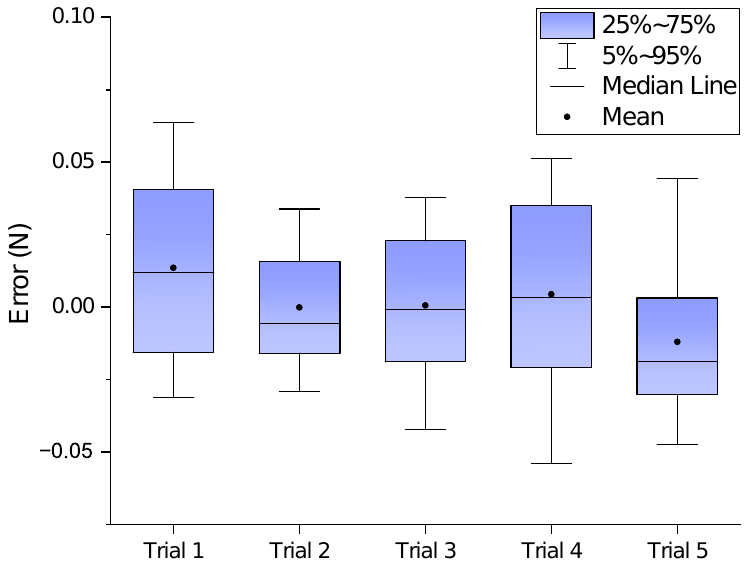
Figure 15. Box-plot of errors at five test experiments with real-time force estimation, where the error is defined as the difference between the predicted and measured guidewire distal